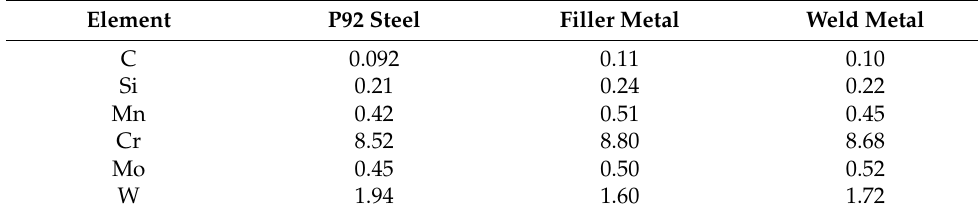
Table 1. Chemical composition of P92 steel, P92 (BOHLER P92-IG) filler and weld metal (wt.%).